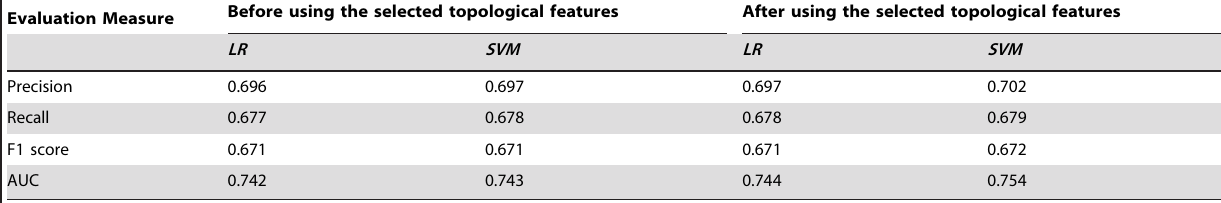
Evaluation Measure